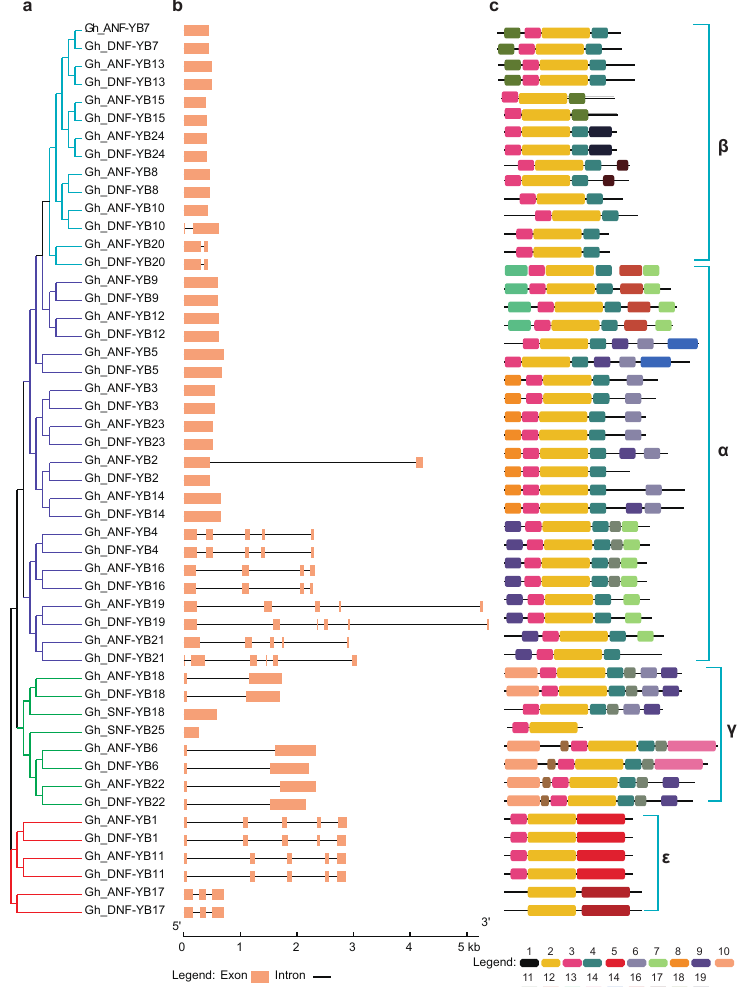
Figure 3. Phylogenetic relationships, exon-intron structures, and conserved motifs of NF-YB genes in Gossypium hirsutum . ( a ) An unrooted tree was constructed in MEGA using the neighbour-joining method, while the four subfamilies are indicated by different colours. ( b ) The pink boxes and black lines indicate exons and introns, respectively. ( c ) The distribution of conserved motifs in GhNF-YB family, where motif 2 represents the B